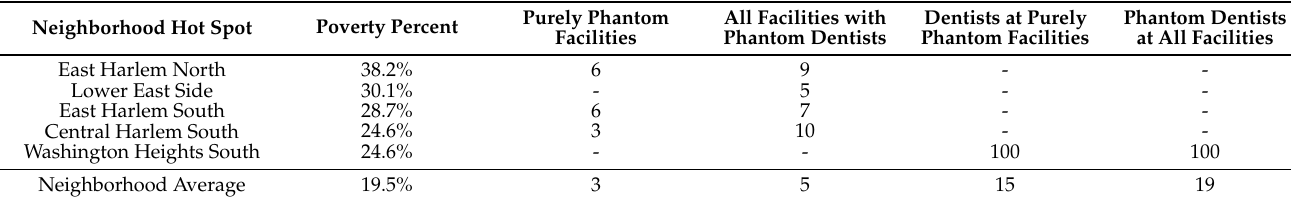
Table 8. A comparison of poverty rates and number of phantom networks by neighborhood where optimized hot spots